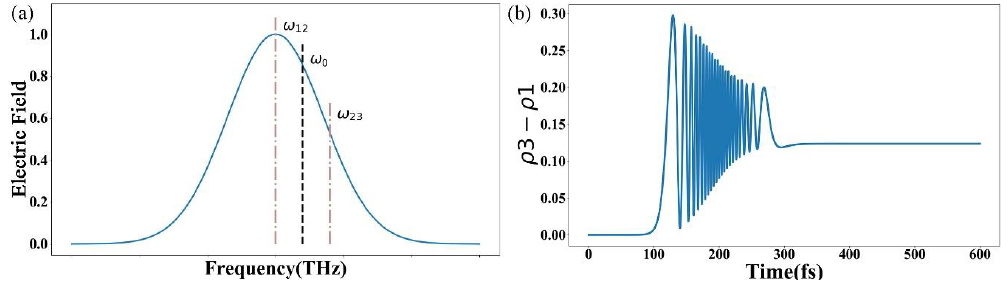
Figure 3. ( a ) The frequency spectrum of the femtosecond laser compared with the energy gap between |1> and |e> (ω 12 ), |g> and |e> (ω 0 ), |3> and |e> (ω 23 ). The intensity of electronic filed ω 12 is twice that of ω 23 . ( b ) Dependence of ρ 3 − ρ 1 on time. ρ 3 − ρ 1 represents the occupation probability difference between states |1> (spin-up) and |3> (spin-down). The spin determines the orientation of magnetization.